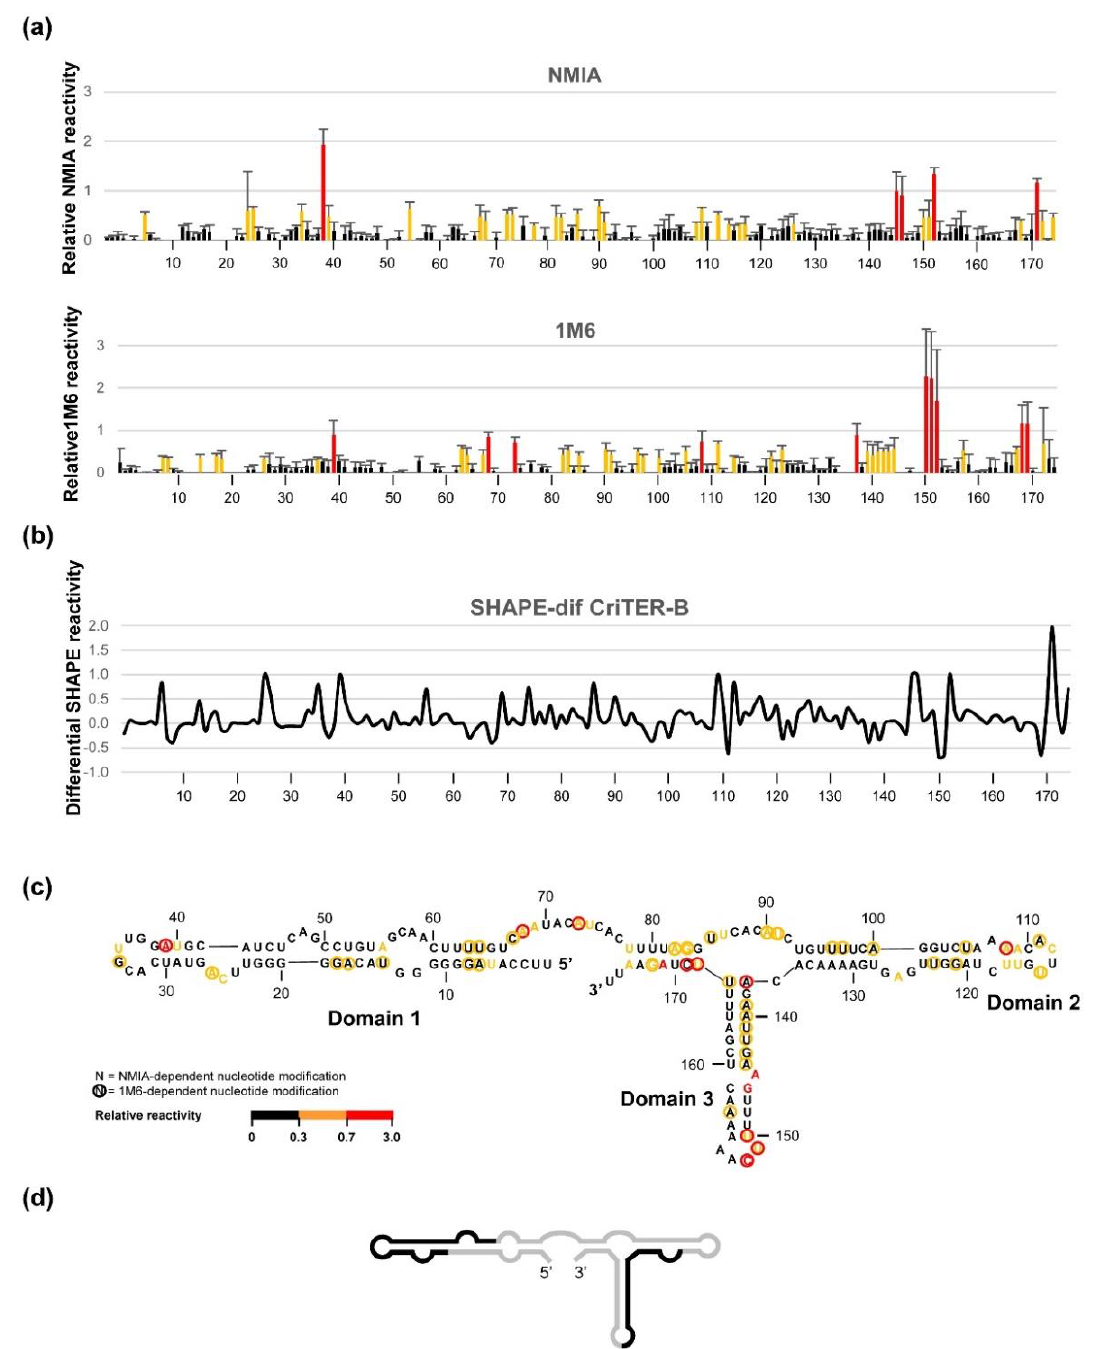
Figure 6. Structural analysis of the CriTER-B telomeric transcript by differential SHAPE. ( a ) Histograms show normalised reactivity of the CriTER-B monomeric RNA with NMIA (top) and 1M6 (bottom) in the presence of Mg 2+ ions at 35 °C. Colours denote the relative nucleotide reactivity from black (lowest) to red (highest) as indicated at the bottom of the figure. Values are the mean of at least three independent experiments ± standard deviation. ( b ) Differential SHAPE reactivities (SHAPE-dif) calculated as described in [29]. ( c ) Putative structure for CriTER-B predicted by RNAStructure based on SHAPE data. ( d ) Schematic secondary structure of CriTER-B. Solid black lines represent regions containing the variable sequence stretches indicated in Figure 2.